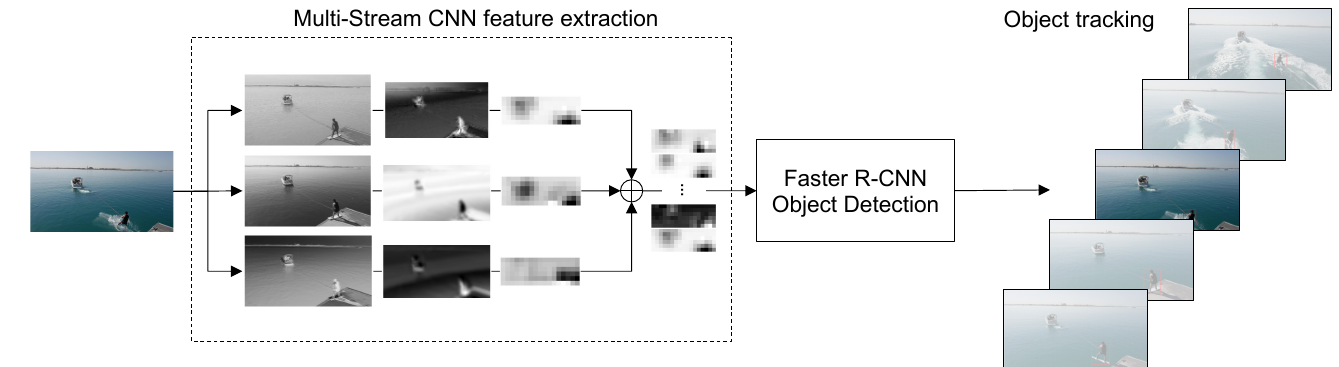
Figure 1. Overview of the proposed object tracking pipeline. Frames from a video sequence are resized to maintain the original aspect ratio. The proposed Multi-Stream CNN analyzes the image through three separate streams, producing feature maps on different details. The maps are then used by the Faster R-CNN object detector, while tracking is finally achieved through the Deep SORT